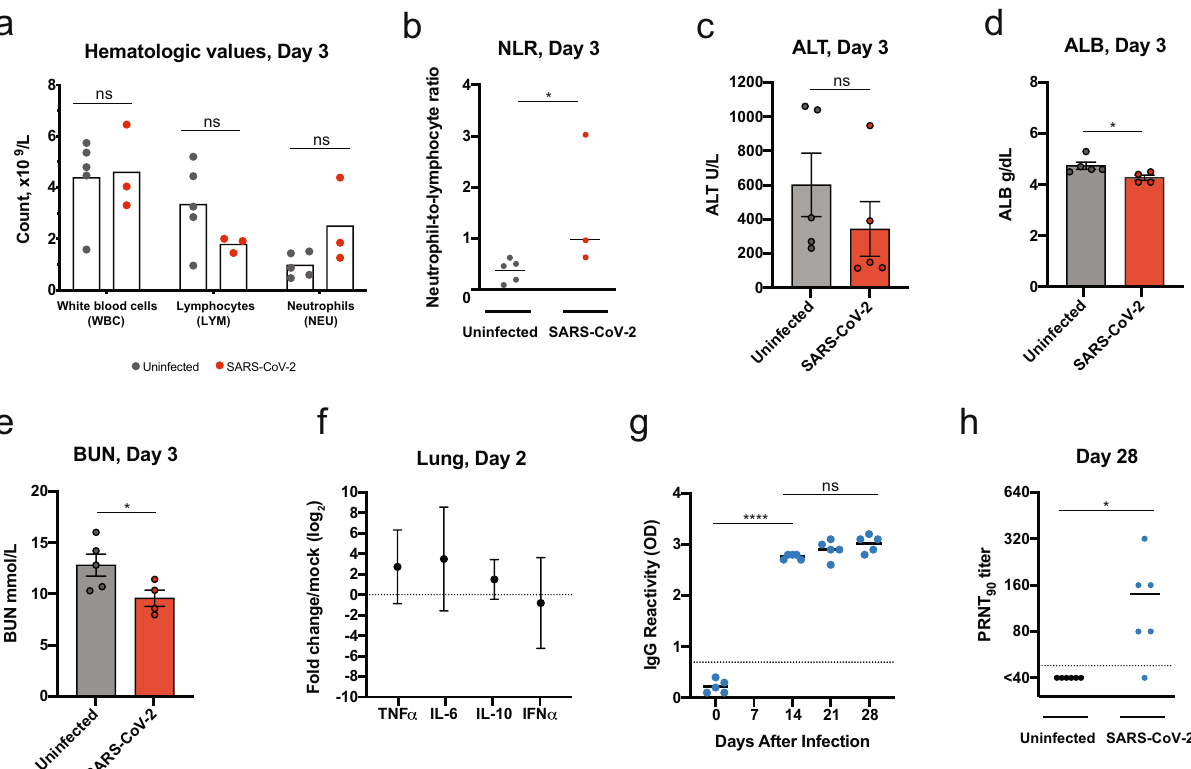
Fig. 4 Deer mouse host response to SARS-CoV-2 infection. a – e Hematological levels and serum biochemistry were measured in uninfected and SARS- CoV-2-infected deer mice (infectious dose 10 6 TCID 50 , i.n. route) at 3 dpi, including ( a ) white blood cell, lymphocyte, and neutrophil counts, ( b ) the neutrophil-to-lymphocyte ratio, ( c ) alanine aminotransferase (ALT), ( d ) blood albumin (ALB), and ( e ) blood urea nitrogen (BUN). f Cytokine gene expression was measured for TNF α , IL-6, IL-10, and IFN α in the lungs of SARS-CoV-2-infected deer mice and displayed relative to age-matched mock- infected animals. Gene expression was normalized using GAPDH as a control. g IgG antibody response against SARS-CoV-2 mixed spike and nucleoprotein (S/N) antigens were assessed by ELISA using serum collected on the indicated days postinfection (infectious dose, 10 5 TCID 50 ). h Neutralizing antibody against SARS-CoV-2 was measured by PRNT 90 using serum collected at 28 days after SARS-CoV-2 infection (infectious dose, 10 5 TCID 50 ). Dotted lines indicate the limit of detection. Solid lines and bars indicate mean, error bars indicate SEM ( c – e ) or 95% con fi dence interval ( f ). Data were collected from two independent experiments ( a , b , n = 5/3 for uninfected/infected; c , n = 5; d , e , n = 5/4 for uninfected/infected, f , n = 6, g , n = 5; h , n = 6 biologically independent samples (individual animals) were examined). * P < 0.05, **** P < 0.0001, ns = P > 0.05; two-sided, unpaired Student t test ( a – e , g – h ), P